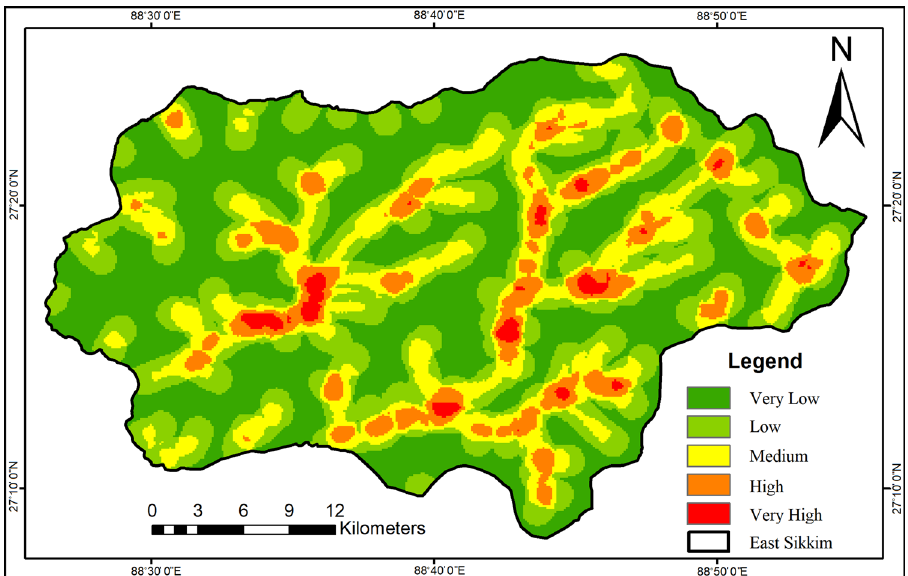
Fig. 9 Drainage density map